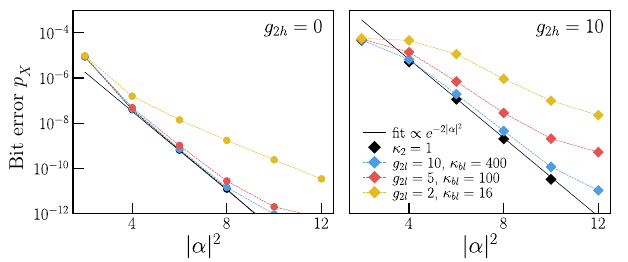
FIG. 18. Bit-flip error probability of an idling qubit for a com- bined TPE and dissipative confinement with single-photon loss = 10 − 3 and thermal noise n = 10 − 2 . The left panel shows κ 1 th numerical simulations without the TPE Hamiltonian and with a single low- Q buffer mode, while the right panel shows numerical simulations with the TPE Hamiltonian and two buffer modes. In both panels, colored lines show different values of g 2, l and κ b , l /κ but at fixed effective two-photon dissipation, κ 2,eff = 4 g 2 b , l , 2, l computed using the adiabatic elimination formula valid at small g 2, l /κ b , l . Black diamonds show reference simulations with the low- Q buffer mode completely eliminated according to this adi- abatic elimination formula, thus actually corresponding to two- photon dissipation κ 2 D [ a 2 − α 2 ]. The black line is a numerical fit of the black diamonds with exponential ratio exp ( − 2 | α | 2 )